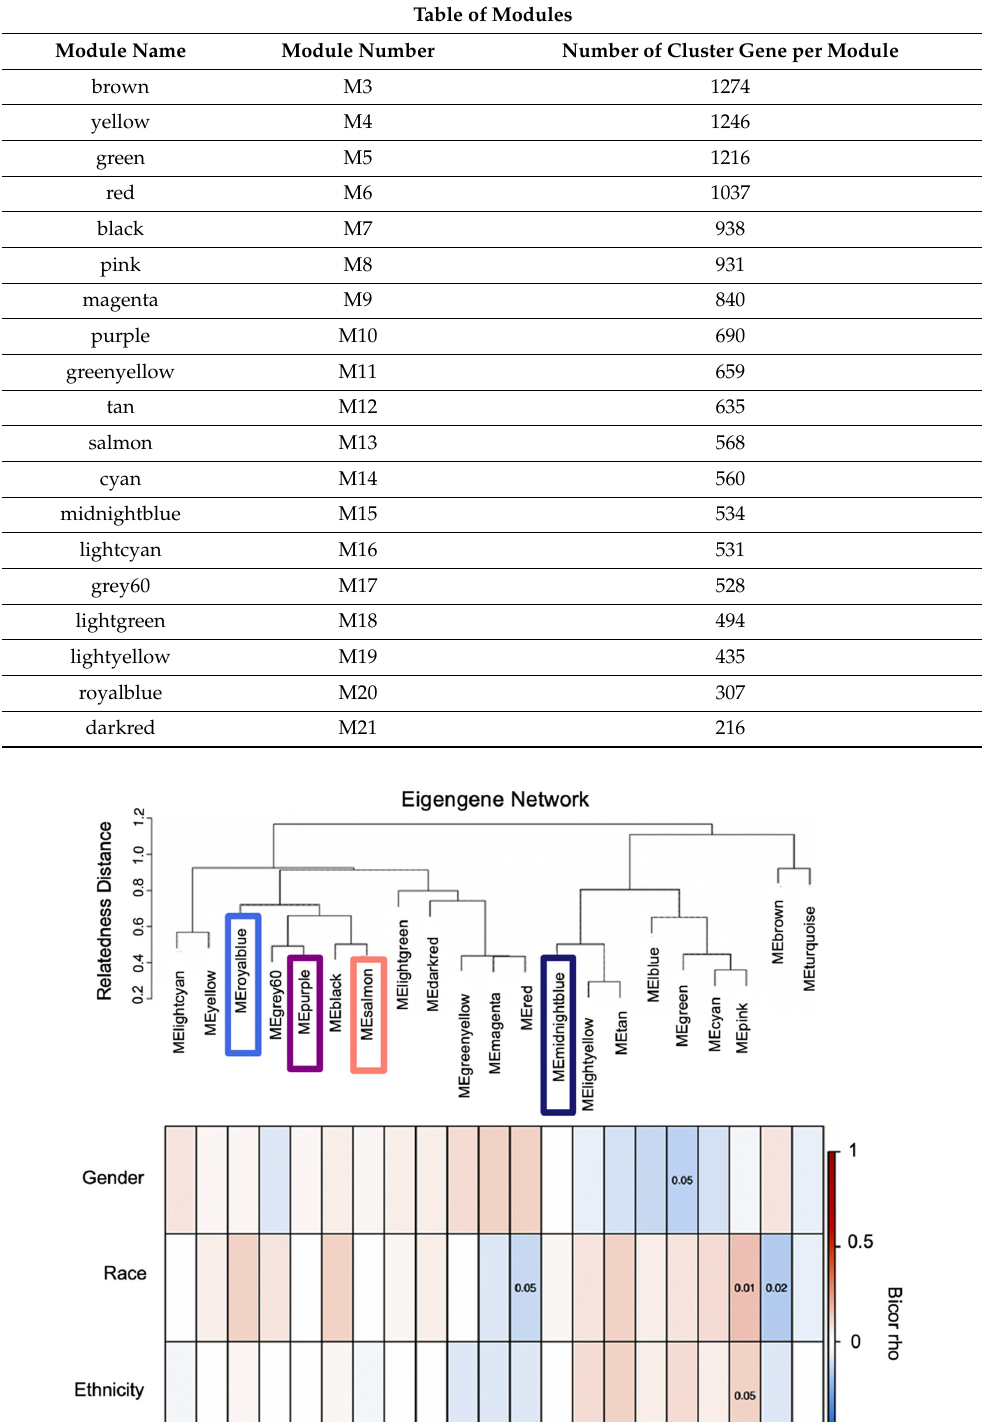
to small size of genes.